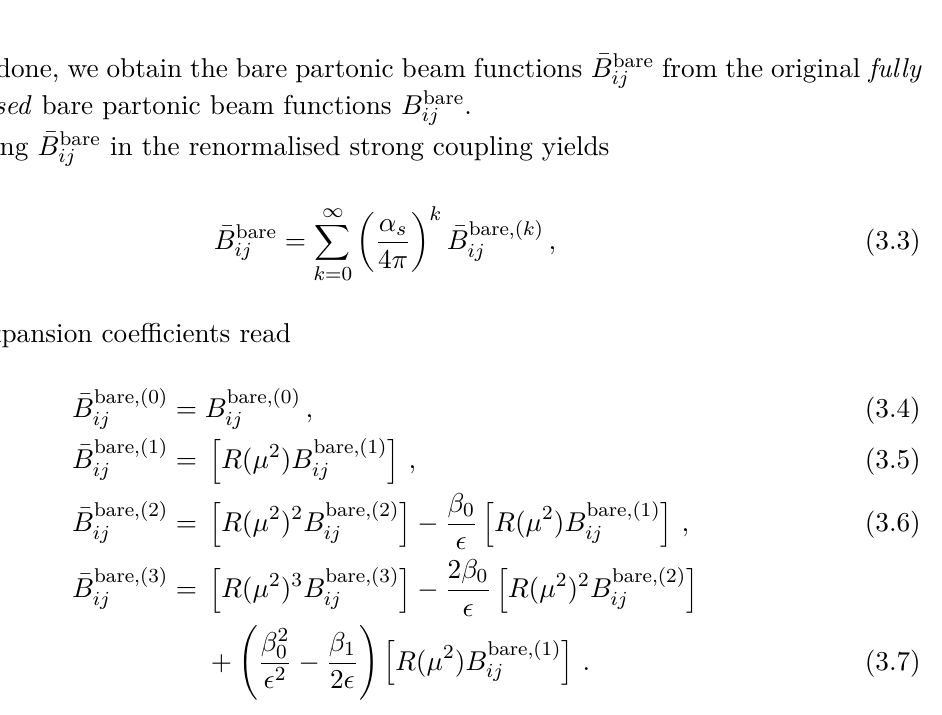
Figure 3 . Steps required for the extraction of the matching coefficients I unrenormalised, bare partonic beam functions B bare previous section. For a detailed description of the steps see the main